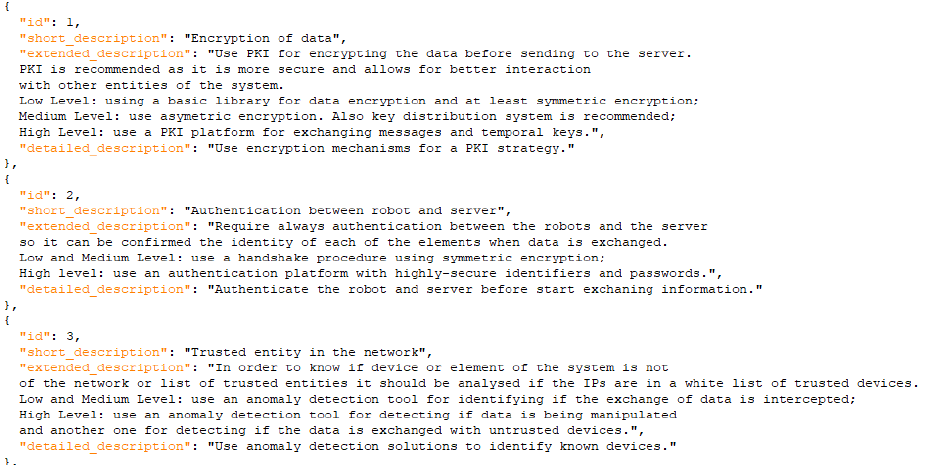
Figure 8. Extract of indicators of the DoS scenario.